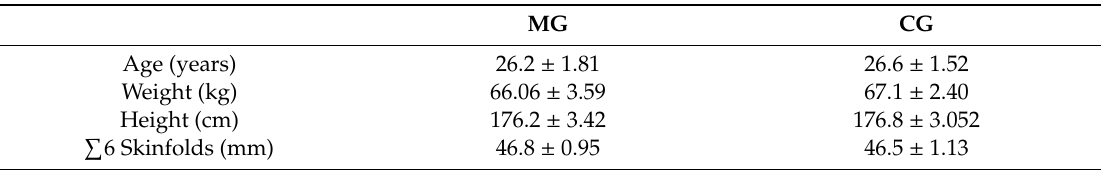
Table 1. Physical and anthropometric characteristics in magnesium supplemented group (MG) and control group (CG) at the beginning of the study (T1).